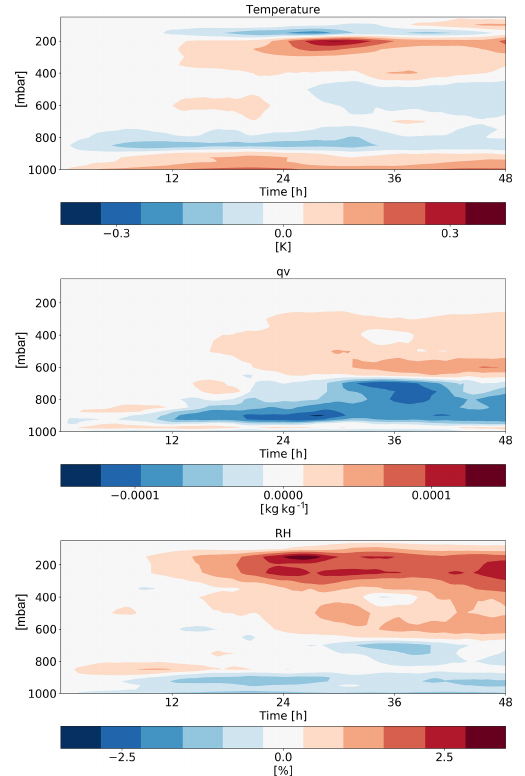
Figure 18. Time–height diagrams of the differences in the domain- mean temperature, specific humidity (qv) and relative humid- ity (RH) vertical profiles between polluted (CDNC = 200cm − 3 ) and clean (CDNC = 20cm − 3 ) simulations for the deep-cloud- dominated case (16–18 August 2016).